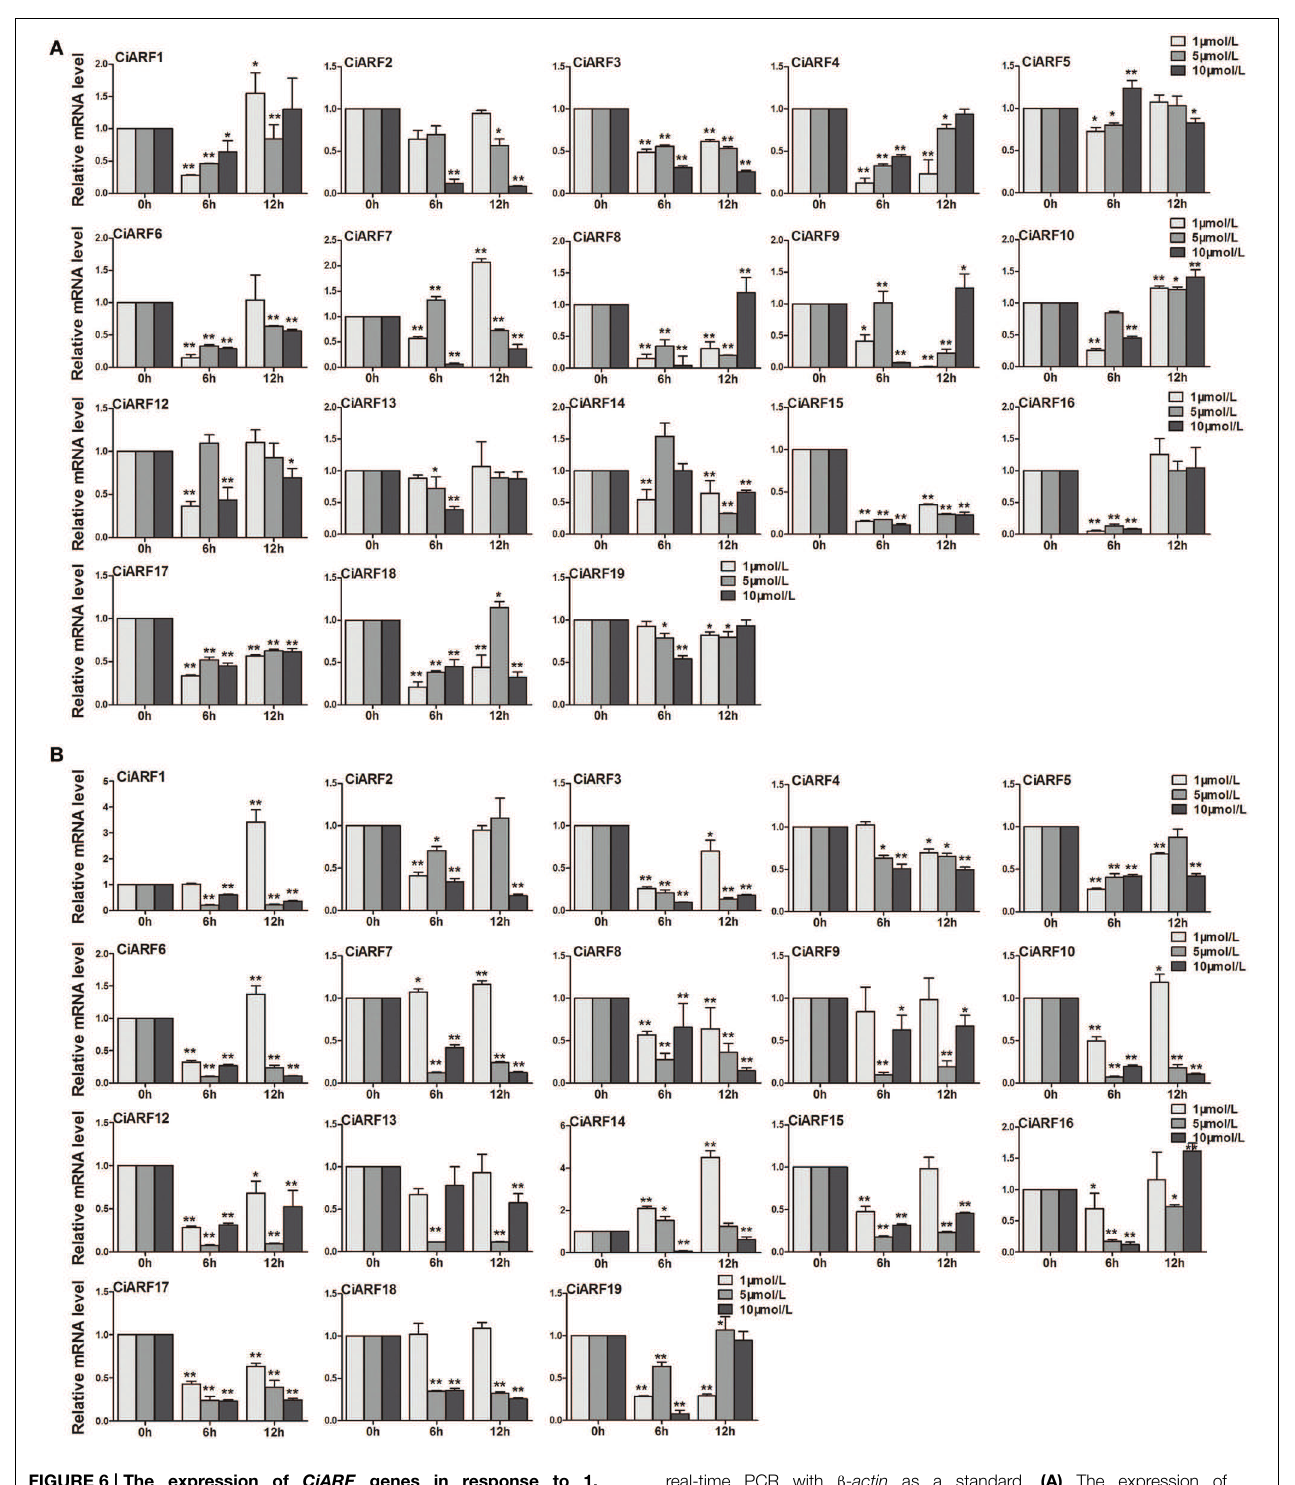
real-time PCR with β - actin as a standard. (A) The expression of CiARF genes by IAA treatment; (B) The expression of CiARF genes by NPA treatment. Data are means ± SE of three separate